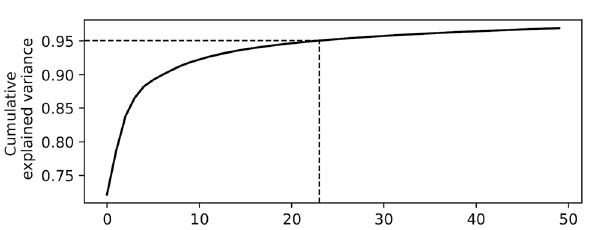
Figure 6. Cumulative percentage of variance explained by the first 50 components of the EOFs decomposition for the temperature monitoring network dataset. The sum of the relative variance of the first 24 components reaches 95% of the total data